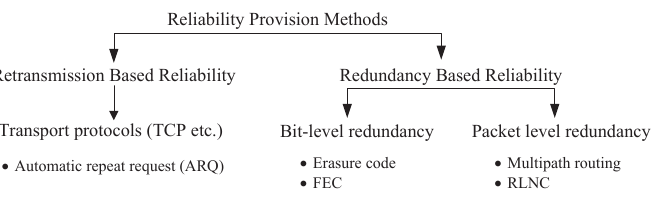
Figure 1. Reliability Provision Methods in wireless multimedia sensor networks